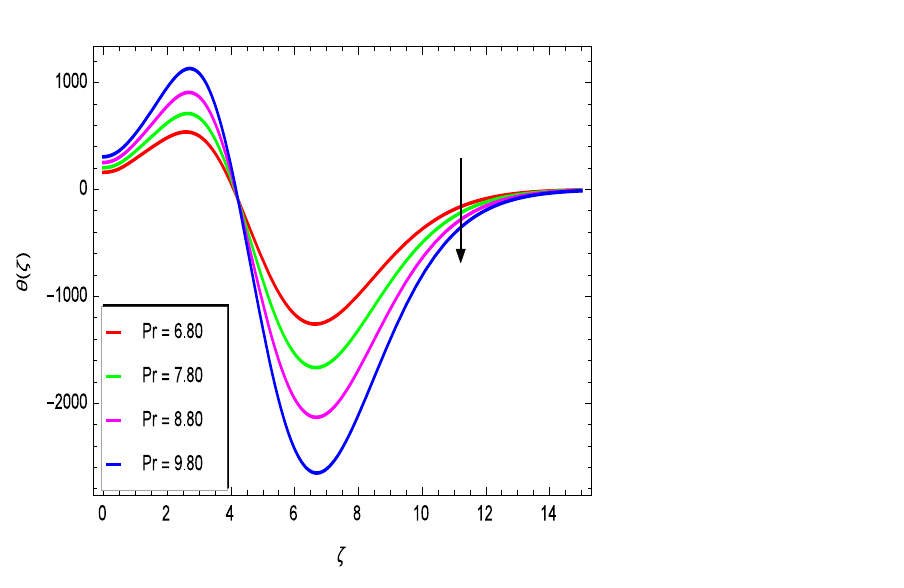
Figure 13. θ(ζ) in terms of Pr